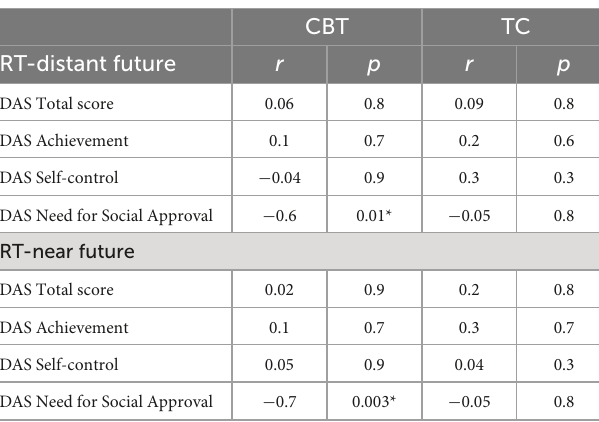
TABLE 3 Spearman’s correlation coefficient between RT for the positive valence of the future and DAS total and subscale